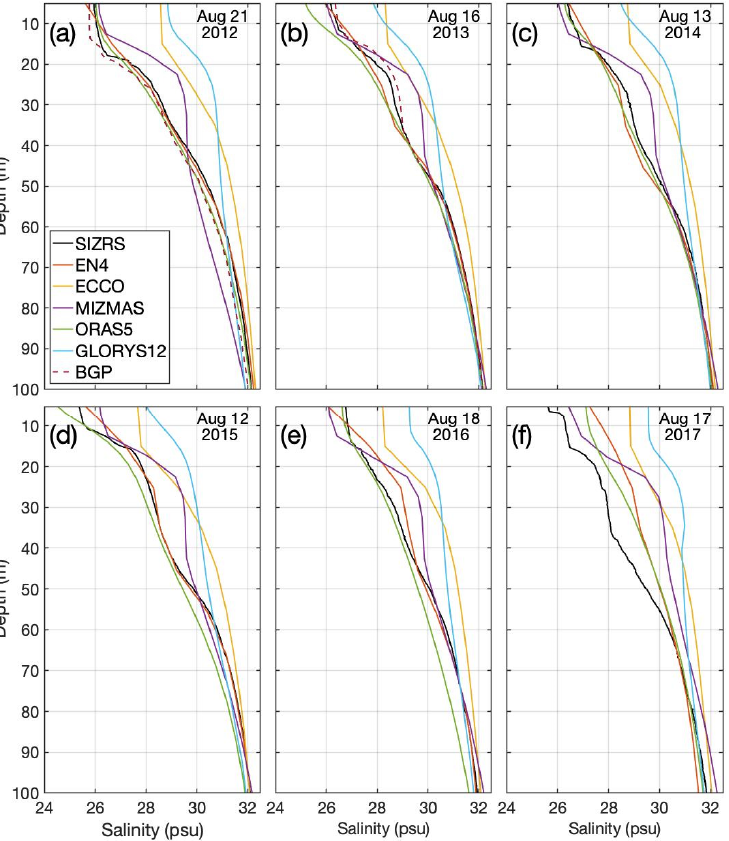
Figure 9. Salinity (psu) depth profile comparisons of SIZRS drops with other products over the transect average (150 ◦ W, 70.5 ◦ N–80.5 ◦ N) during ( a ) 21 August 2012, ( b ) 16 August 2013, ( c ) 13 August 2014, ( d ) 12 August 2015, ( e ) 18 August 2016, ( f ) 17 August 2017.